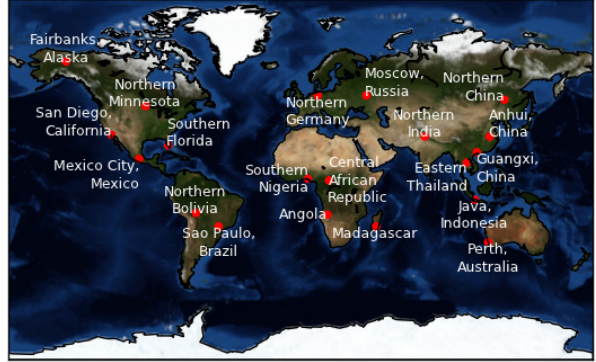
Figure 5. Selected 1 ◦ × 1 ◦ grid cells for a sensitivity analysis on C e scatter plots and values based on using different threshold param- eters and settings are identified on this MODIS true-color image. These sites were selected with the intention of maintaining diversity in location, fire type, biome, number of data points, and expected goodness-of-fit of linear